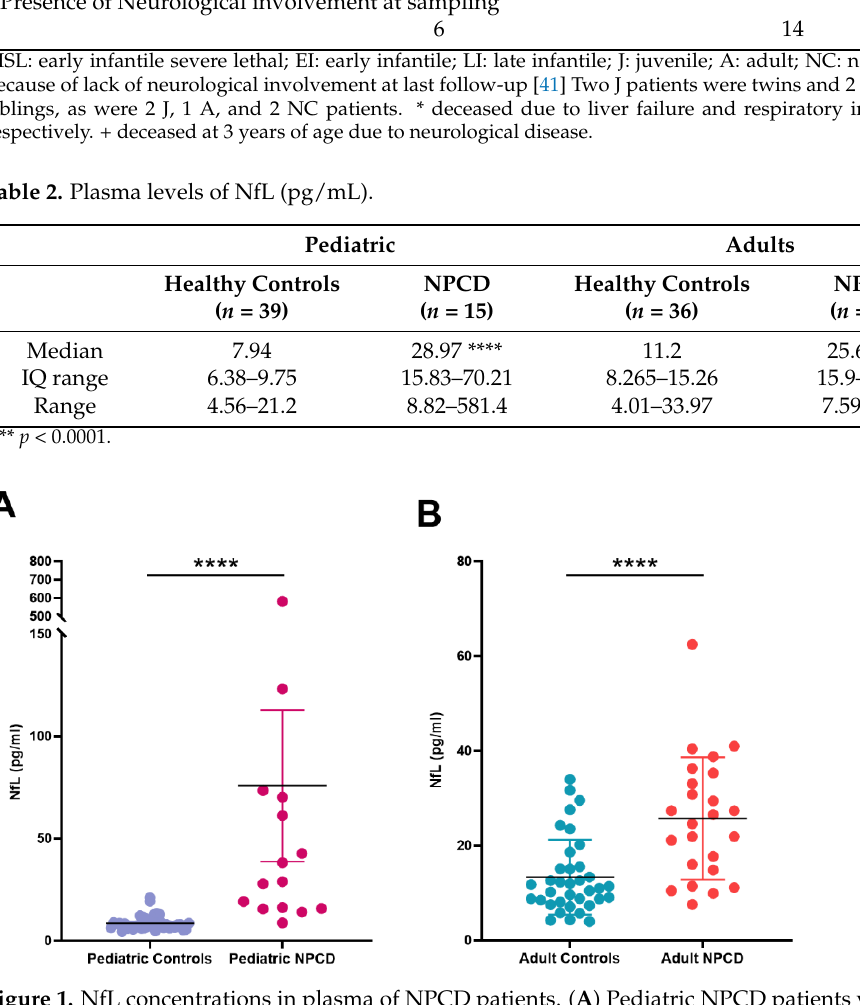
Figure 1. NfL concentrations in plasma of NPCD patients. ( A ) Pediatric NPCD patients vs. healthy controls. ( B ) Adult NPCD patients vs. healthy controls. **** p < 0.0001.